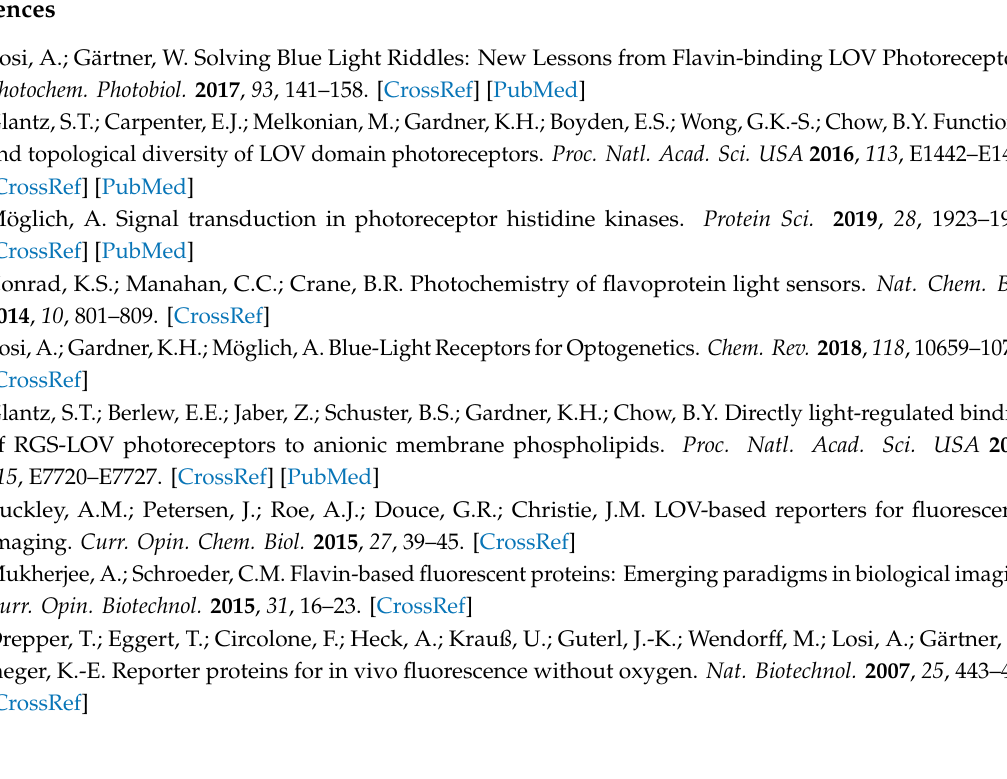
Figure S1: Normalized absorption spectra of CagFbFP and its proline-substituted variants, Figure S2. Normalized fluorescence excitation spectra of CagFbFP and its proline-substituted variants, Figure S3. Normalized fluorescence emission spectra of CagFbFP and its proline-substituted variants, Figure S4. Omit (polder) maps for the mutants, (a) A56P and (b) A95P. The original structure of CagFbFP (PDB ID 6RHF) is shown in green, the structures of the mutants are shown in magenta. Polder electron density maps (green) are contoured at the level of 3 × r.m.s, Figure S5. Root mean square deviations of backbone atom positions as a function of time. Dimers of proteins harboring the conformers A and B of the residue 58 were simulated both for the WT and A58P variants for 3 times (runs 1–3). The values were averaged over 1 ns time intervals. Some trajectories, such as WT B run 1, display relatively high overall RMSD as a consequence of displacement of one protomer relative to another one. Structures of individual protomers are conserved well in all simulations (Figure S6), Figure S6. Root mean square fluctuations of backbone atom positions as a function of residue number during the last 40 ns of the simulations. Trajectory snapshots of each of the two protomers from each simulation were aligned and analyzed separately, and labeled chain A or chain B. No clear di ff erences in the flexibility of di ff erent elements of the WT and A58P mutant variants are evident from the